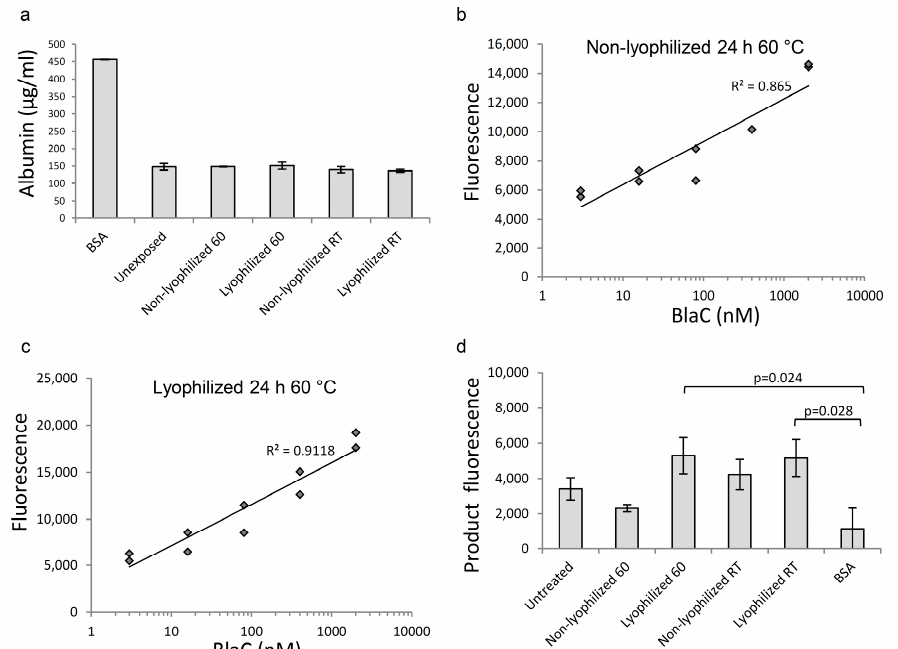
Figure 8. Blue Sepharose retains the ability to deplete albumin following lyophilization and exposure to adverse temperatures. Non-lyophilized Blue Sepharose was exposed to RT and 60 ◦ C for 24 h and tested for the ability to bind albumin. ( a )—effect of temperature on the albumin-binding ability of Blue Sepharose in lyophilized and non-lyophilized forms, two experimental replicates, error bars = standard deviation; ( b )—The relationship of BlaC concentration and fluorescent signal in the buffer spiked with albumin and treated with Blue Sepharose that was exposed 24 h to 60 ◦ C in non-lyophilized form; ( c )—The relationship of BlaC concentration and fluorescent signal in the buffer spiked with albumin and treated with Blue Sepharose that was exposed 24 h to 60 ◦ C in lyophilized form; ( d )—Fluorescence of CDG-3 cleavage product with subtracted background signal in albumin-spiked buffers, treated with lyophilized and non-lyophilized Blue Sepharose (30 min of BlaC treatment, 404 nM BlaC). Only two comparisons (shown on the panel) are significantly different. Two